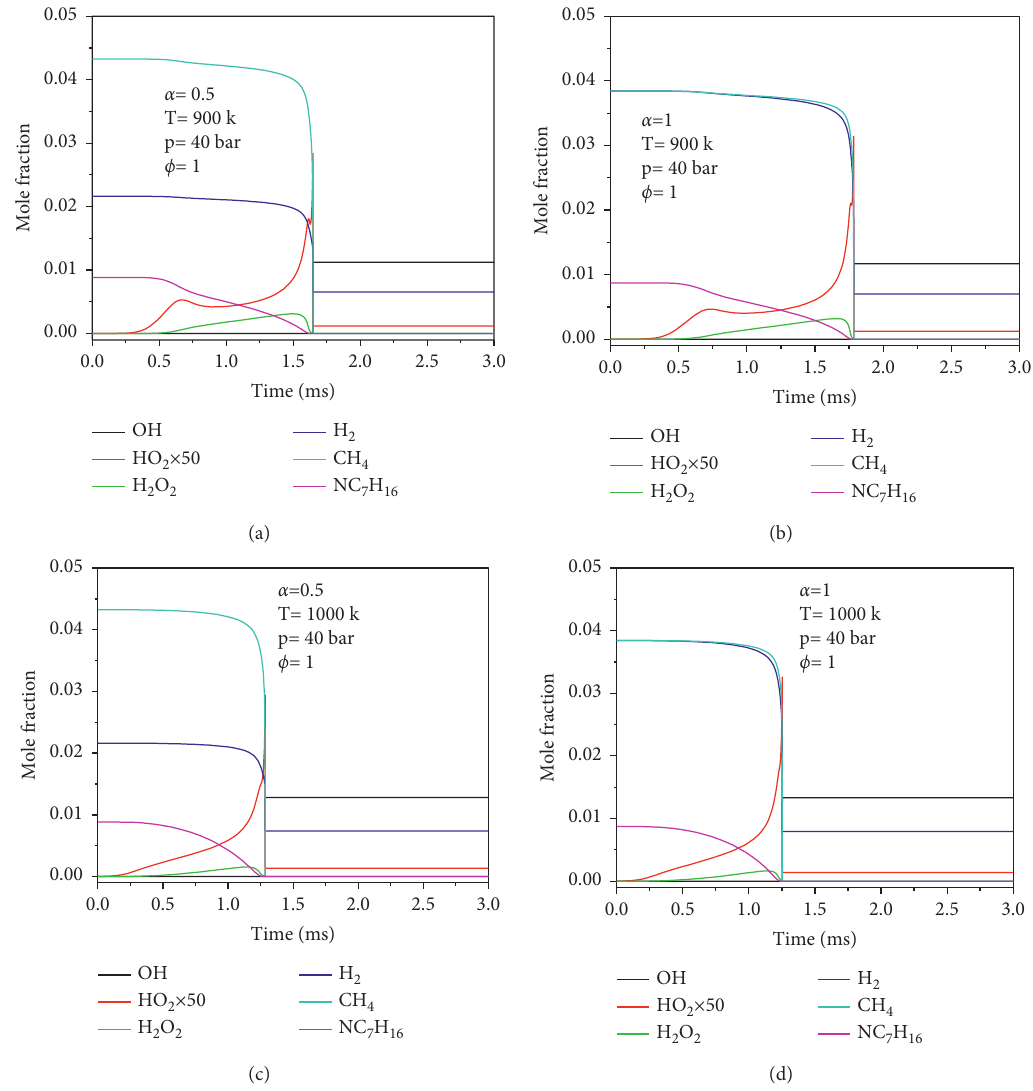
Figure 7: Effect of initial temperature and α on species evolution for methane/H ϕ �